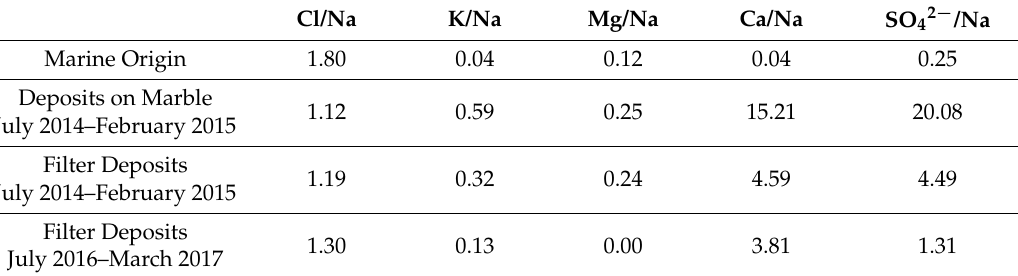
Table 3. Elemental ratios of interest for the determination of chloride contribution of marine origin calculated for quartz fiber filters and marble specimens exposed on the Duomo façade during the two periods. Cl/Na K/Na Mg/Na Ca/Na SO 42 −